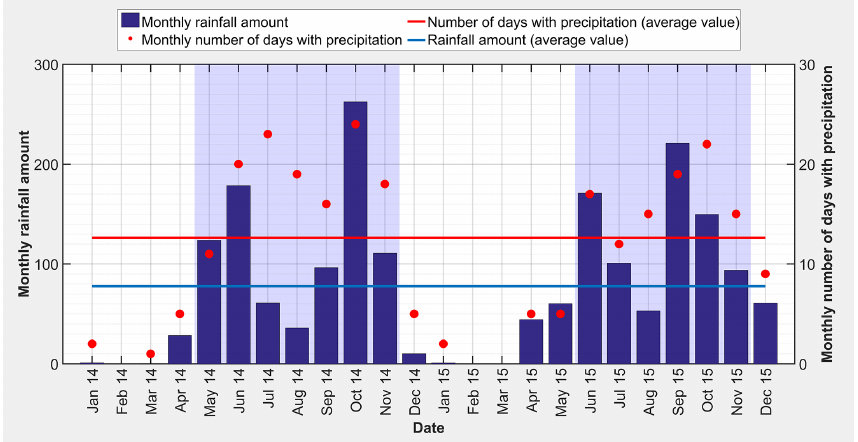
Figure 2. Monthly precipitation (mm) and a monthly number of days with precipitation for the Cao Lanh station. Light blue background indicates rainy